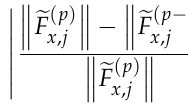
Figure 5. Non-dimensional wave forces ( a ) acting on the cylinders with d / b = 4, β = 0 ◦ and h i = 1 m. Numbering of cylinders 1-2-3-4 (red dots), 1-2-4-3 (green dots), 1-4-3-2 (orange dots), 2-3-4-1 (blue dots), Ren et al. [19] (black line).